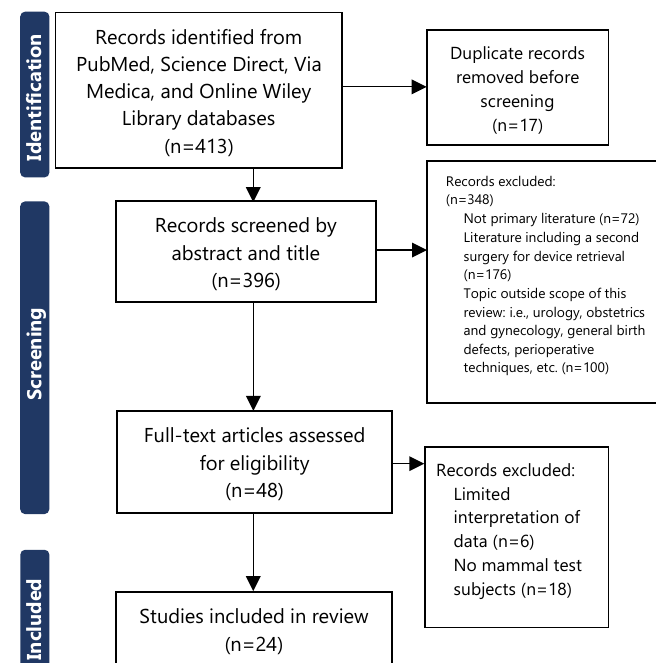
Figure 2 . PRISMA Study